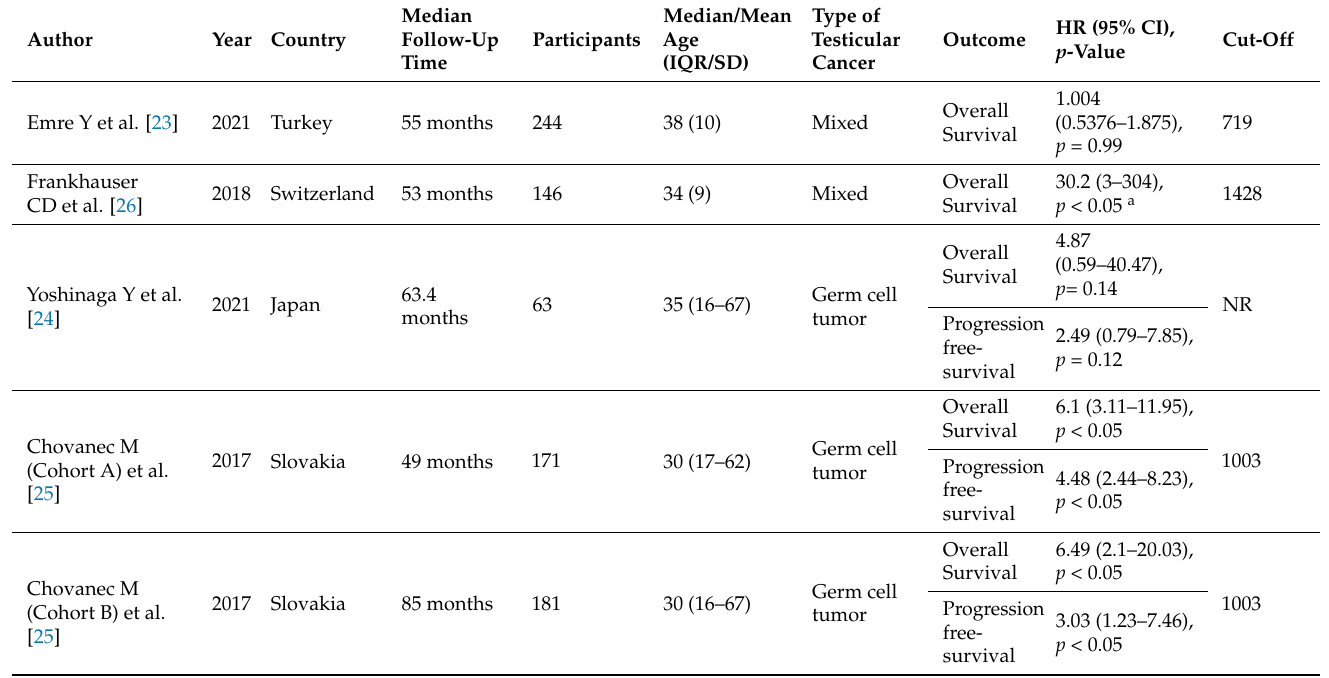
Table 1. Characteristics of the included studies.